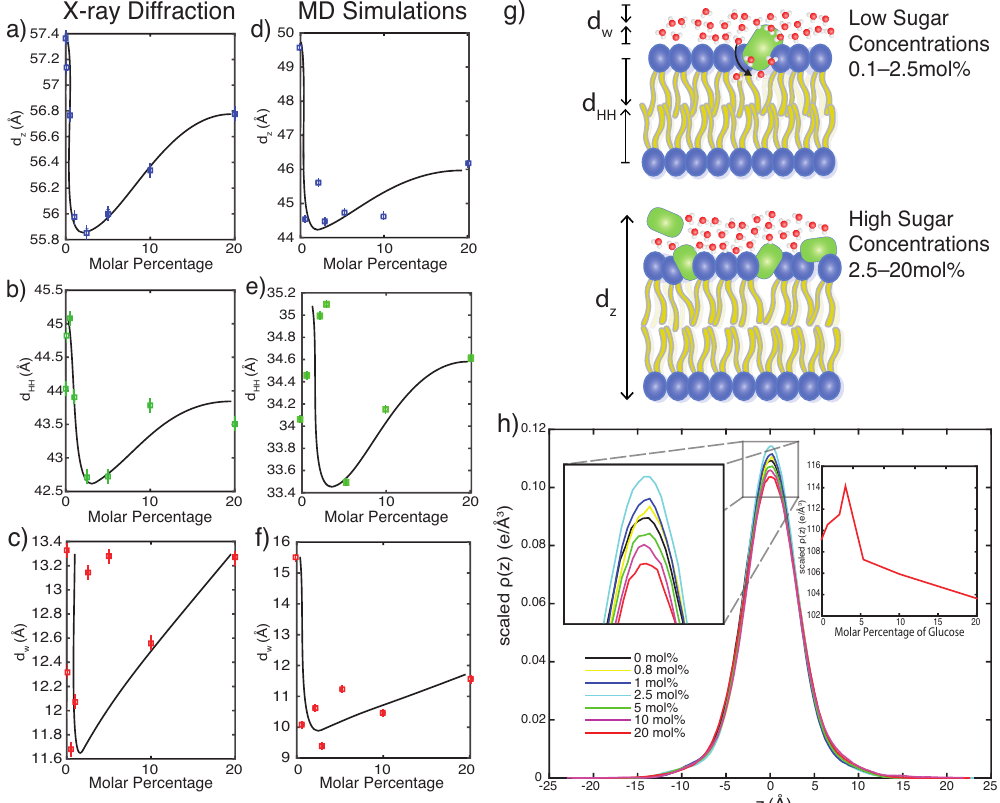
Figure 7. Bilayer thickness parameters from experiments ( a – c ) and simulations ( d – f ). Lamellar spacing d z , membrane width d HH , and water layer thickness d w are found to decrease sharply at low concentrations, and gradually increase towards higher glucose concentrations. ( g ) Schematic of non-monotonic behavior for bilayers at low and high glucose concentrations. ( h ) Electron density profiles for the core component (terminal methyl carbons of the phospholipid acyl chains) from MD simulations (from Figure 2b,c). The height of this peak is a measure of interdigitation, as it displays the relative probability of phospholipids occupying the centre of the bilayer. Insets show close-ups of the region between 2.5 Å < z < 2.5 Å. Increased interdigitation is seen at low glucose concentrations but − decreases as glucose content